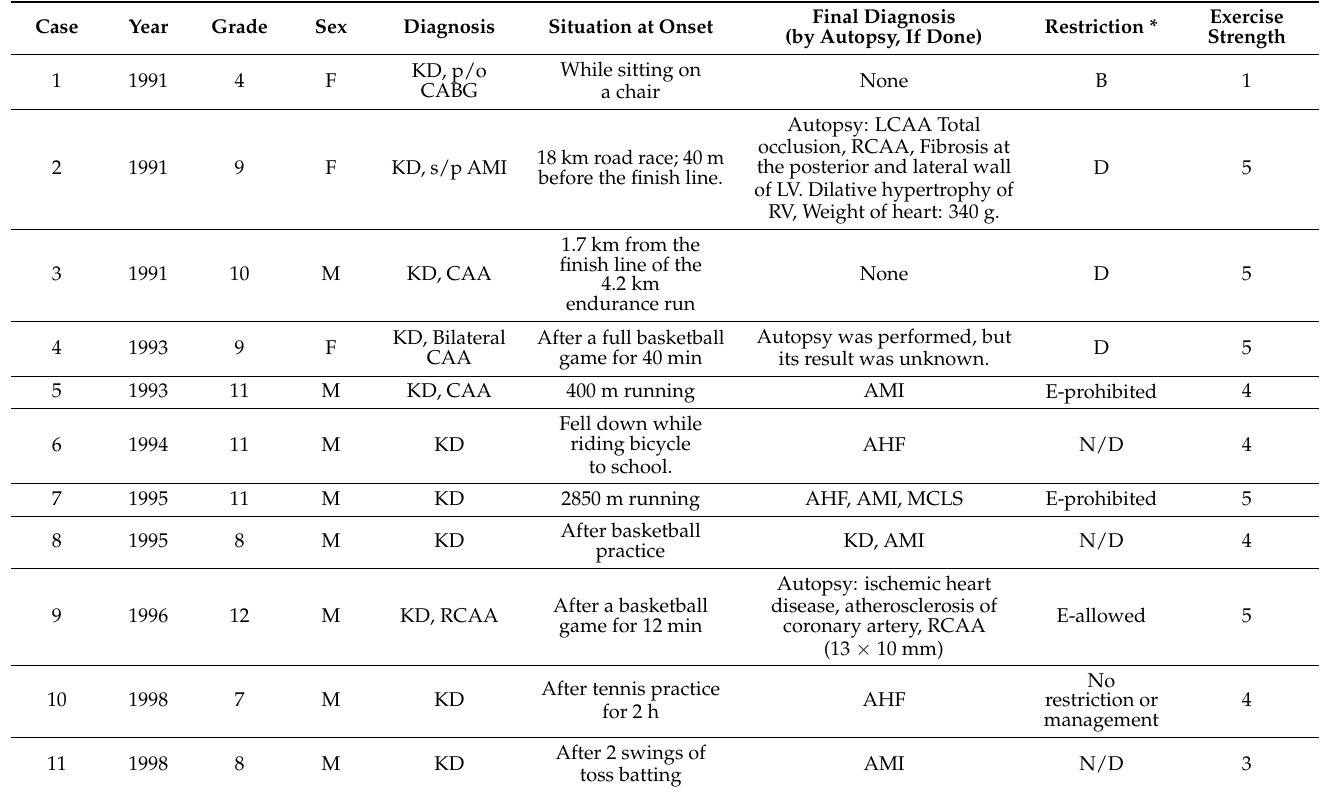
Table 1. Cases of sudden death in students with a history of Kawasaki disease under school supervi- sion